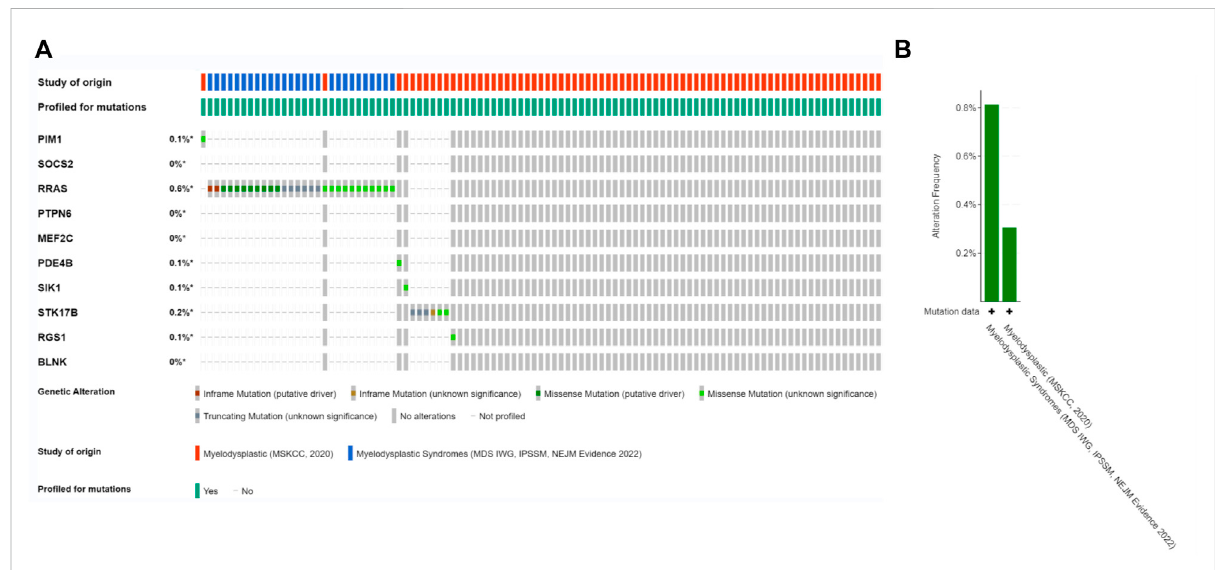
FIGURE 8 Genetic alterations. (A) Representation of genetic alterations showing genetic alterations in 10 key genes, which were altered in 756 (1%) of 7554 MDS patients; (B) illustrates the total frequency of alterations in 10 hub genes.